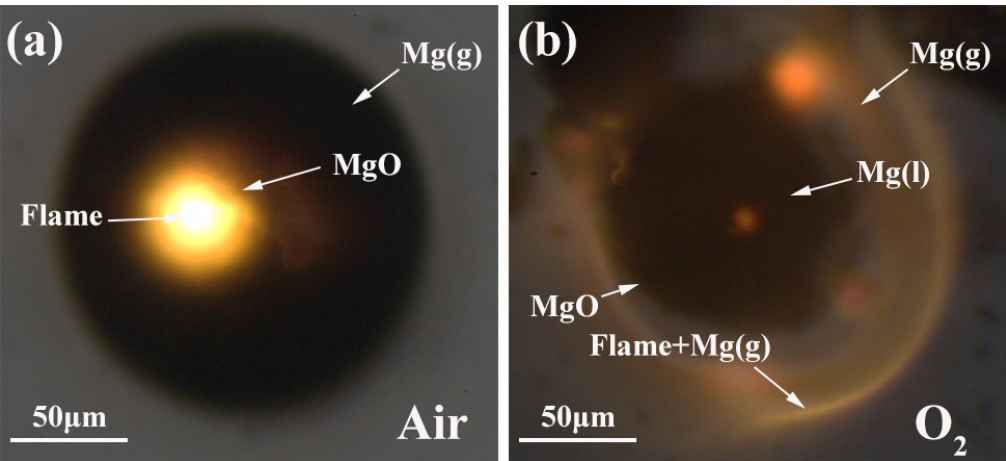
Figure 8. Representative snapshots of the vapor-phase stand-off flame of burning Mg microparticles, ( a ) in air; ( b ) in O 2 .